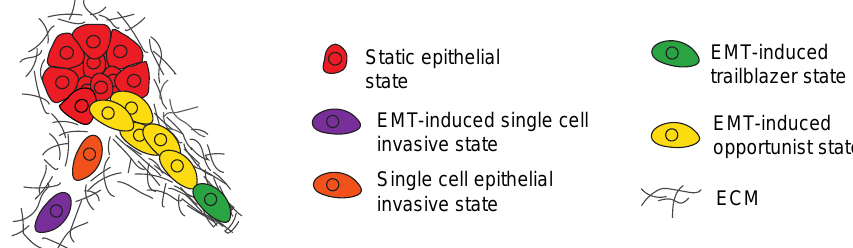
Figure 3. Model shows how a subpopulation of EMT induced cells can promote the invasion of siblings that lack intrinsic invasive properties. EMT induced cells (purple) can promote single cell invasion of sibling epithelial tumor cells (orange) through paracrine signaling. Cells in a trailblazer EMT state (green) can create paths in the ECM then promote the collective invasion of siblings in an opportunist EMT state (yellow).